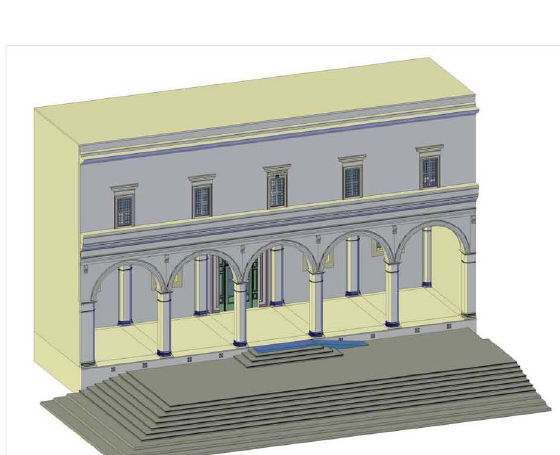
Figure 20. Axonometric view of the virtual model of the entrance of Basilica of San Pietro in Vincoli in Rome